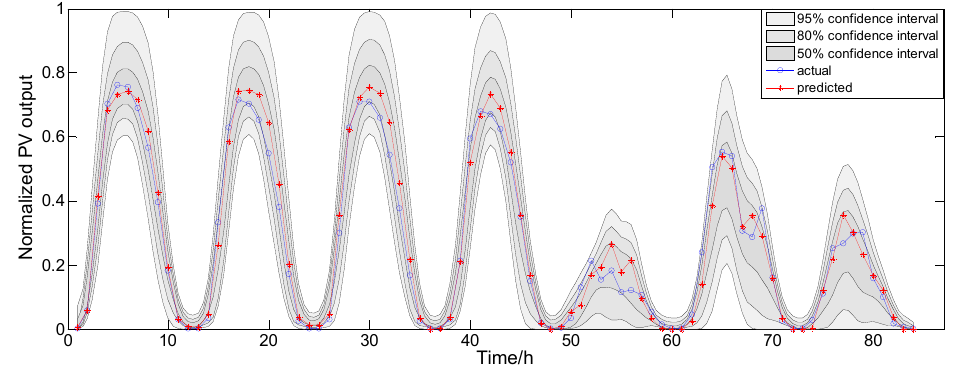
Figure 7. Point forecast and interval forecast over seven days using IMLSSVM.